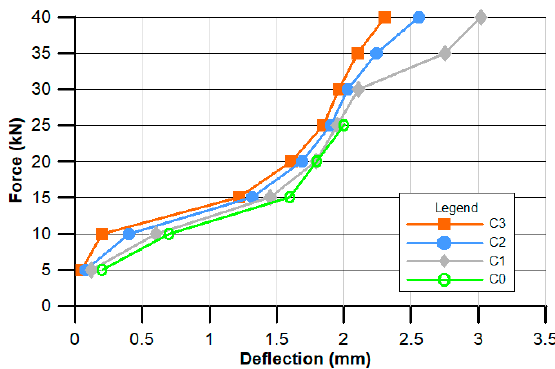
Figure 9. Experimental relationships between concentrated force and deflection.